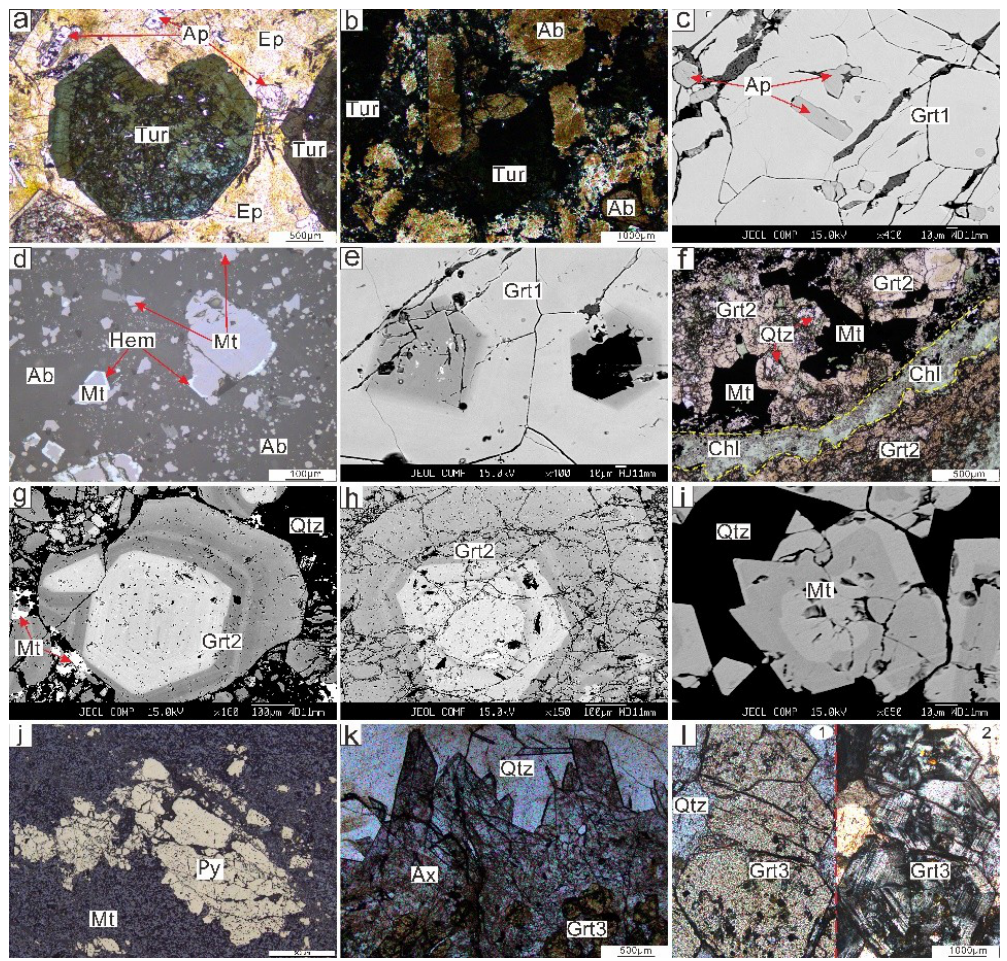
Figure 5. Photomicrographs of representative samples from different stages and their relationships in the Yamansu deposit. ( a ) Tourmaline (growth zonation) and apatite (fine-grained) crystals replaced by epidote (plane polarized light); ( b ) Albite crystals replaced or enclosed by tourmaline along their rims (cross polarized light); ( c ) Granular and rod-shaped apatite enclosed by Grt1 (back-scattered electron (BSE) image); ( d ) Disseminated euhedral to anhedral magnetite crystals with diversely 5–100 μm grains that are intergrown with albite and replaced by hematite (reflected light); ( e ) Grt1 characterized by core–rim growth zonation (BSE image); ( f ) Grt2 (with yellow cores and pale rims) show replacement by magnetite and quartz, or cut by chlorite vein (plane polarized light); ( g ) A Grt2 shows well-preserved growth zonation and replaced by magnetite and quartz (BSE image); ( h ) Euhedral Grt2 with growth zonation of irregular core (BSE image); ( i ) Magnetite crystals in massive ores have continuous alternate zonation with a brighter central zone and replaced by quartz (BSE image); ( j ) Magnetite crystals coexisting with sulfide (mainly fine to coarse grained pyrite) have xenomorphic shapes (BSE image); ( k ) Axinite (stumpy wedge or rhomboidal) and quartz superimposed on the Grt3 (plane polarized light); ( l ) Zoned Grt3 (with oscillatory zoning in the rims) accompanied with quartz (plane polarized light in 1 and cross polarized light in 2). Abbreviations: Tur—Tourmaline;